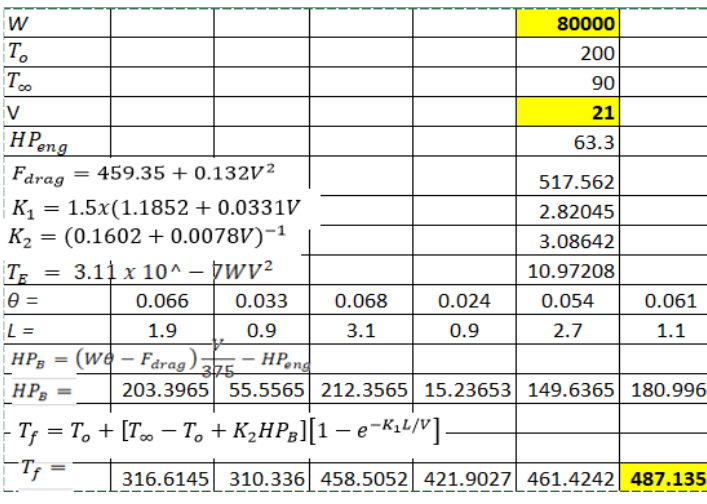
Figure 8: Validation of temperature of descent for a scenario of the continuous downgrade method (Excel